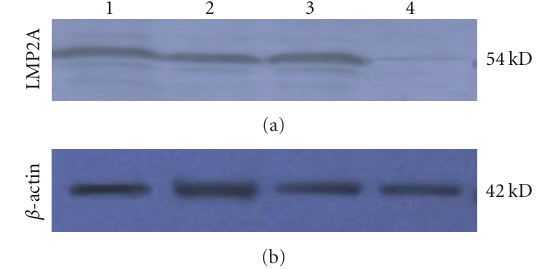
Figure 6: The expression of LMP2A protein in vAd-2A-infected SGC cells by Western Blotting β -actin was used for internal control, lane 1, 2, 3: vAd-2A-infected SGC cells; lane 4: vector control (SGC-